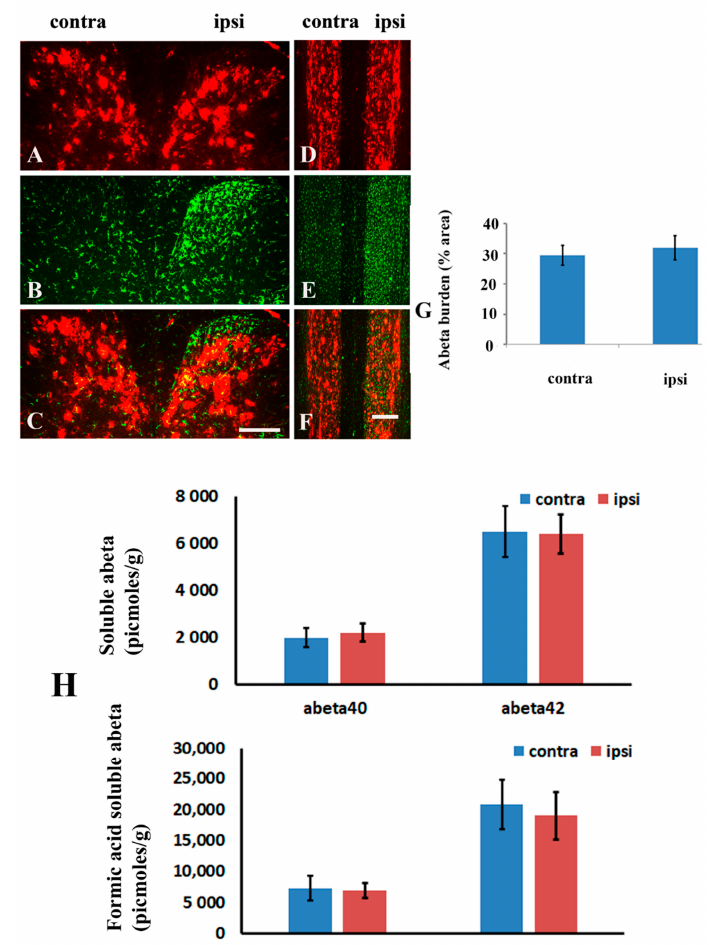
Figure 6. Representative cross ( A – C ) and horizontal ( D – F ) sections of cervical cord stained with antibodies against A β and IBA-1 in the spinal cord of 20 month-old TgCRND8 mice at 28 days following nerve ligation. ( G ): Quantitative data showed that microglia activation did not diminish A β plaque deposition in the ipsilateral side (ipsi) compared to the contralateral side (contra) following nerve ligation. Scale bar in ( C ), 100 μ m. ( H ): Soluble and insoluble A β 40 or A β 42 levels in the contralateral and ipsilateral dorsal horn of the spinal cord of TgCRND8 mice at 28 days following the spinal nerve injury by ELISA assay. Scale bar in ( F ), 200 μ m.